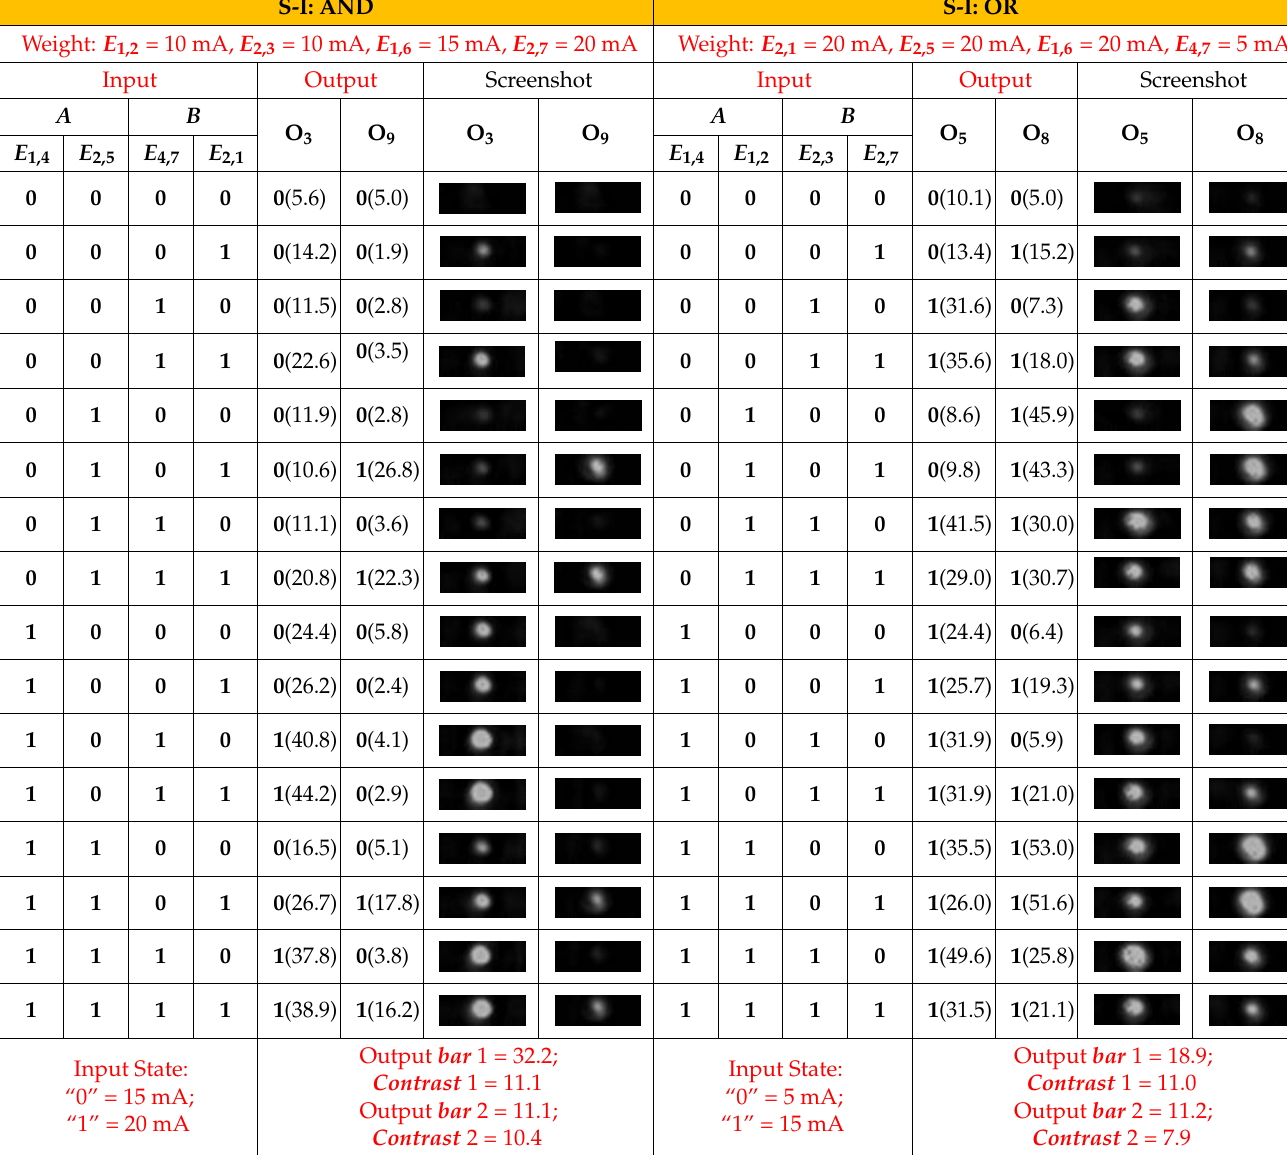
Table 2. AND and OR gate settings of S-I. [Input- ∀ , Weight- ∀ , Output- ∀ ] . S-I: AND S-I: